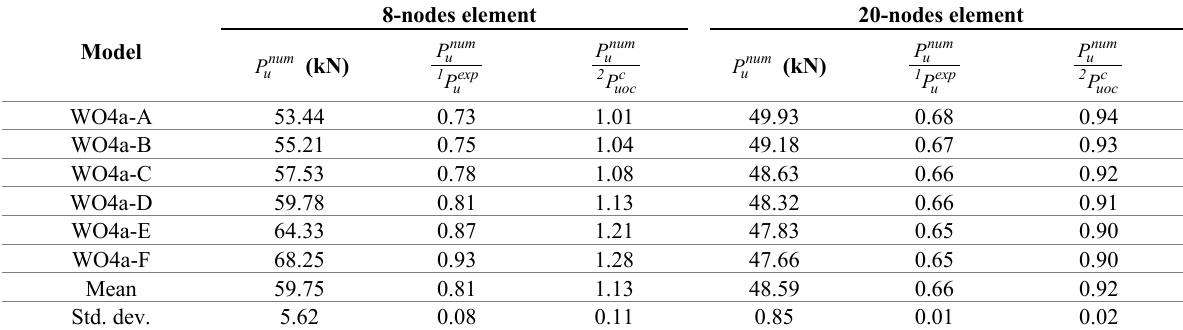
Table 6. Ultimate loads obtained from non-strengthened models with 8 and 20 nodes elements.